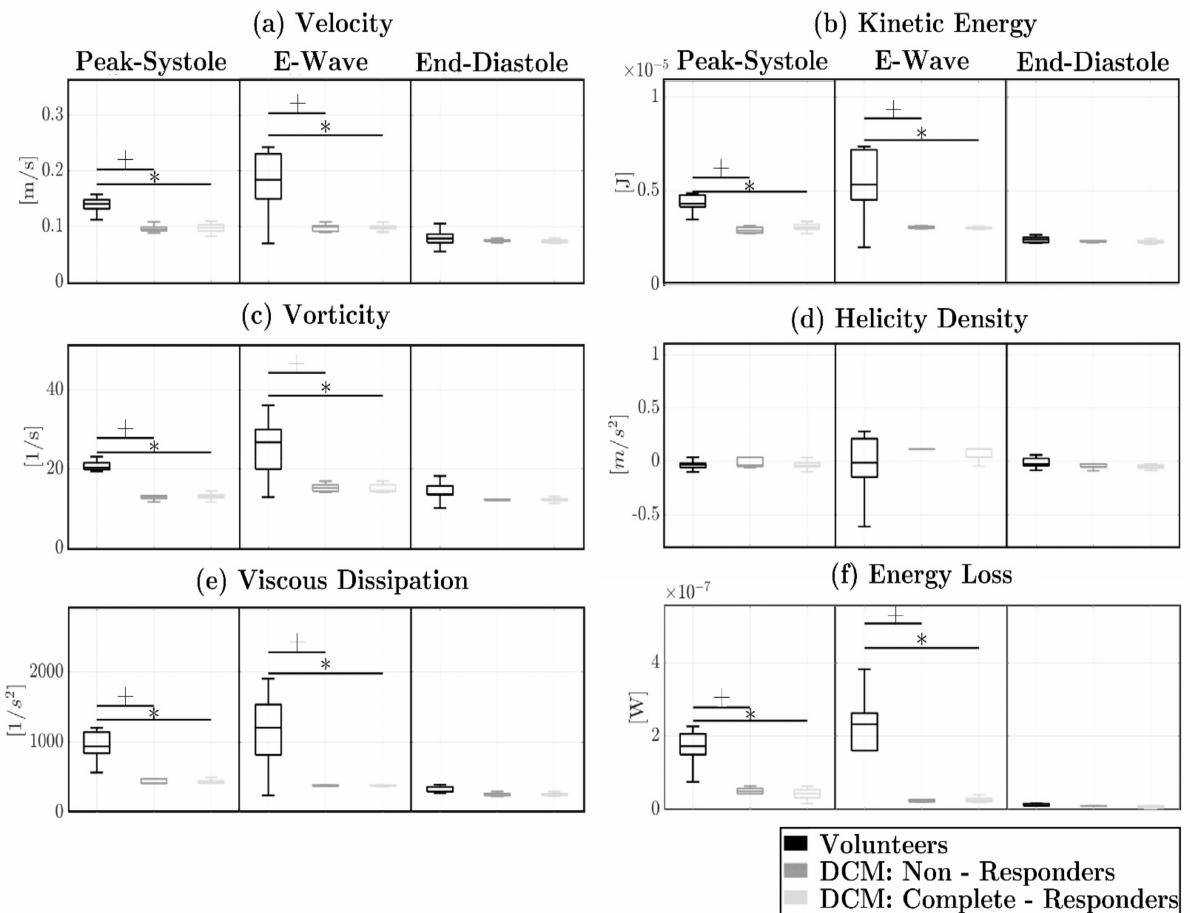
Figure 2. Box whisker plots for hemodynamic parameters ( a – f ) in the entire LV cavity of HV and DCM patients groups at peak systole, e-wave, and end-diastole. On each box, the central mark is the median, the bottom and top edges of the box are the 25th and 75th percentiles, respectively, and the whiskers extend to the most extreme data points not considered outliers. *,+ Indicates statistically significant differences ( p <